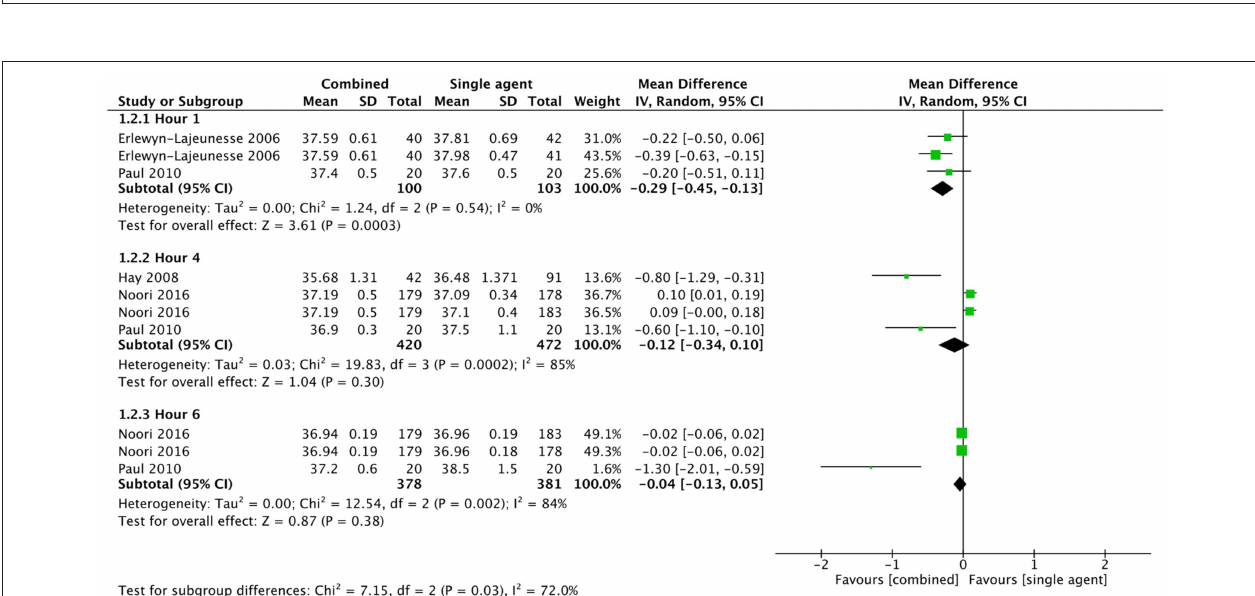
FIGURE 4 | Comparison: combined vs. single agent, Outcome: proportion remaining febrile.